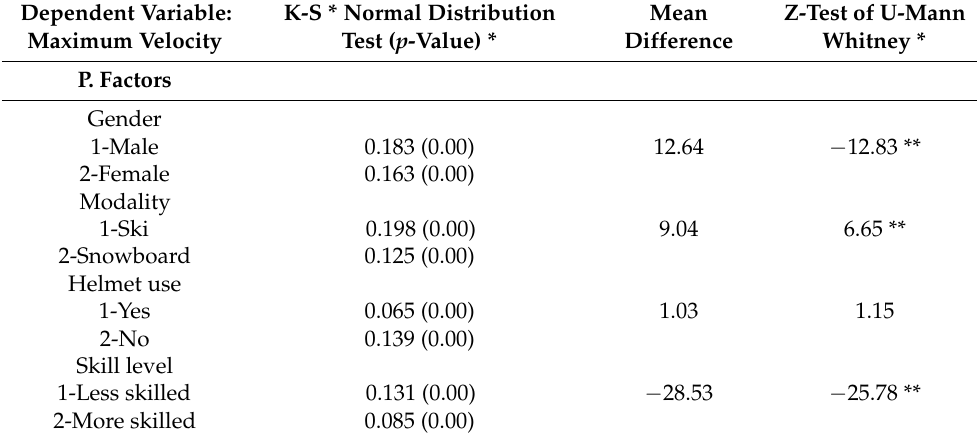
Table 2. Contrast of mean differences of maximum velocity according to personal characteristics.